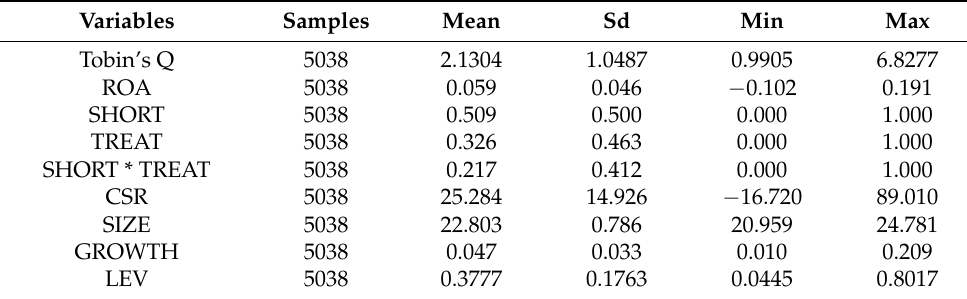
Table 4. Descriptive statistics of